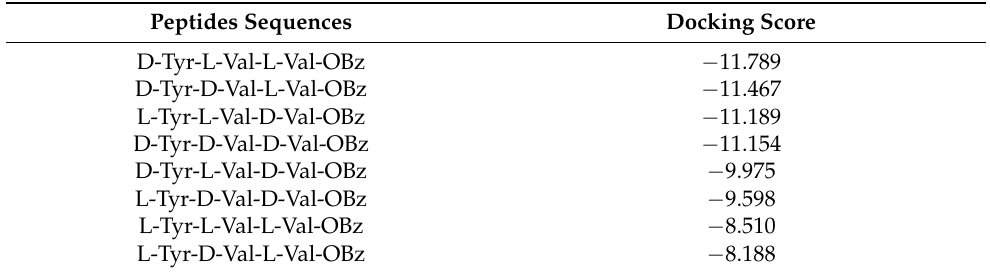
Table 1. Docking score values for the designed peptides based on the insertion of valine in third position (second approach).